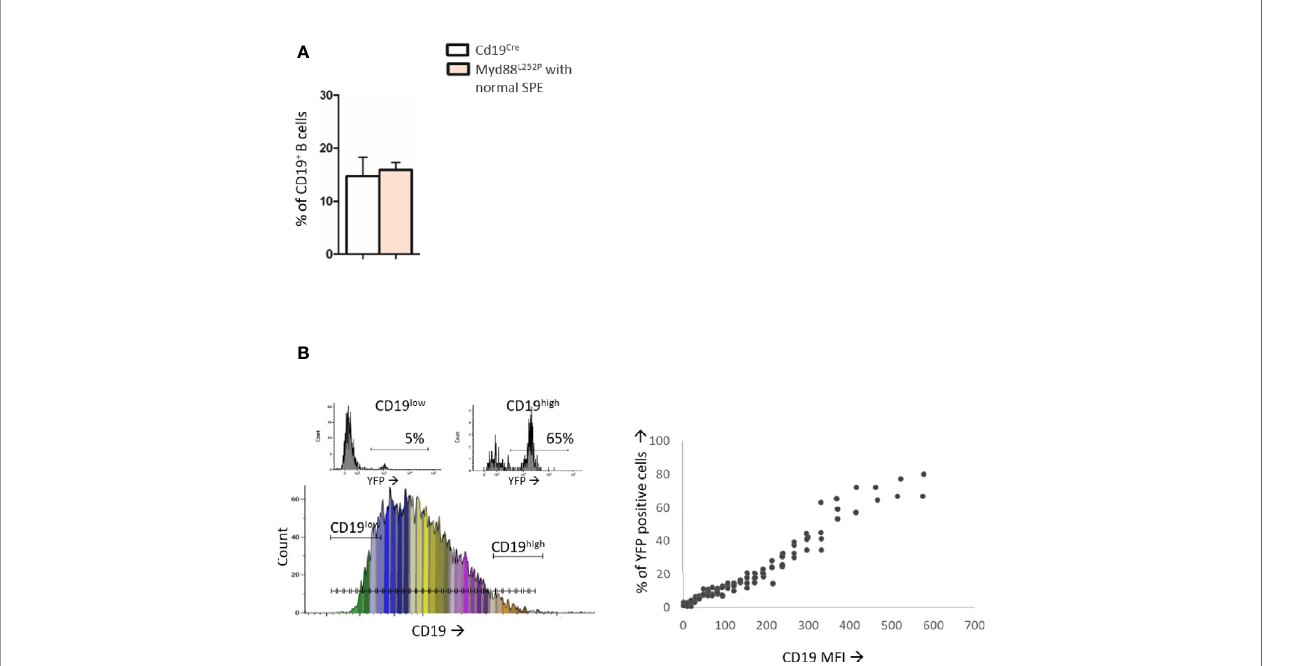
FIGURE 2 | Analysis of B-cell differentiation in bone marrow from 16 week-old Cd19 Cre and Myd88 L252P mice. (A) : Percentage of CD19 pos and/or B220 pos B-cells in bone marrow from 16 week-old Cd19 Cre (n =9) and Myd88 L252P mice (n = 9). Results are expressed as the mean ± SEM. (B) : Flow cytometry analysis of the transgene expression according to CD19 expression levels (n=9). Left panel: CD19 monoparametric histogram sliced according to CD19 MFI intervals. For each CD19 MFI interval, the percentage of bone marrow B220 pos YFP positive cells was noted. Two examples of YFP monoparametric histograms are presented in the upper part, one for CD19 low B220 pos B-cells and one for CD19 high B220 pos B-cells with their respective percentages of YFP pos cells Right panel: percentage of YFP pos B220 pos B-cells (Y axis) according to CD19 MFI (X